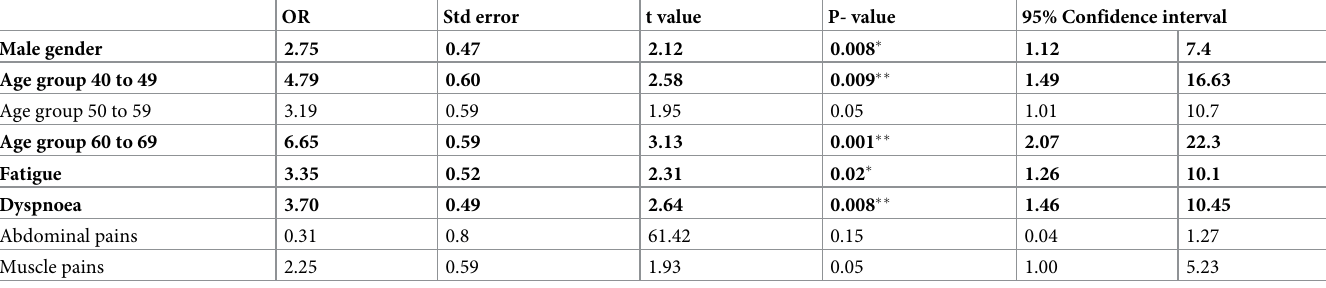
Table 4. Multivariable analysis of symptoms associated with COVID-19